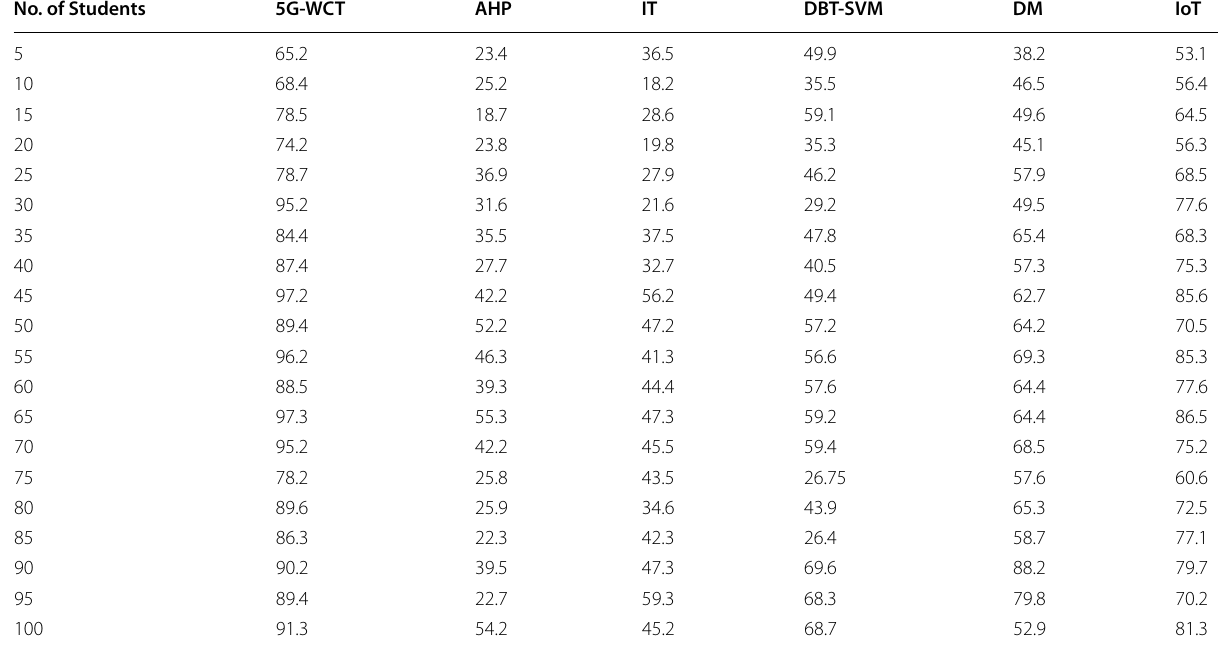
Table 1 Error rate analysis in teaching quality No. of